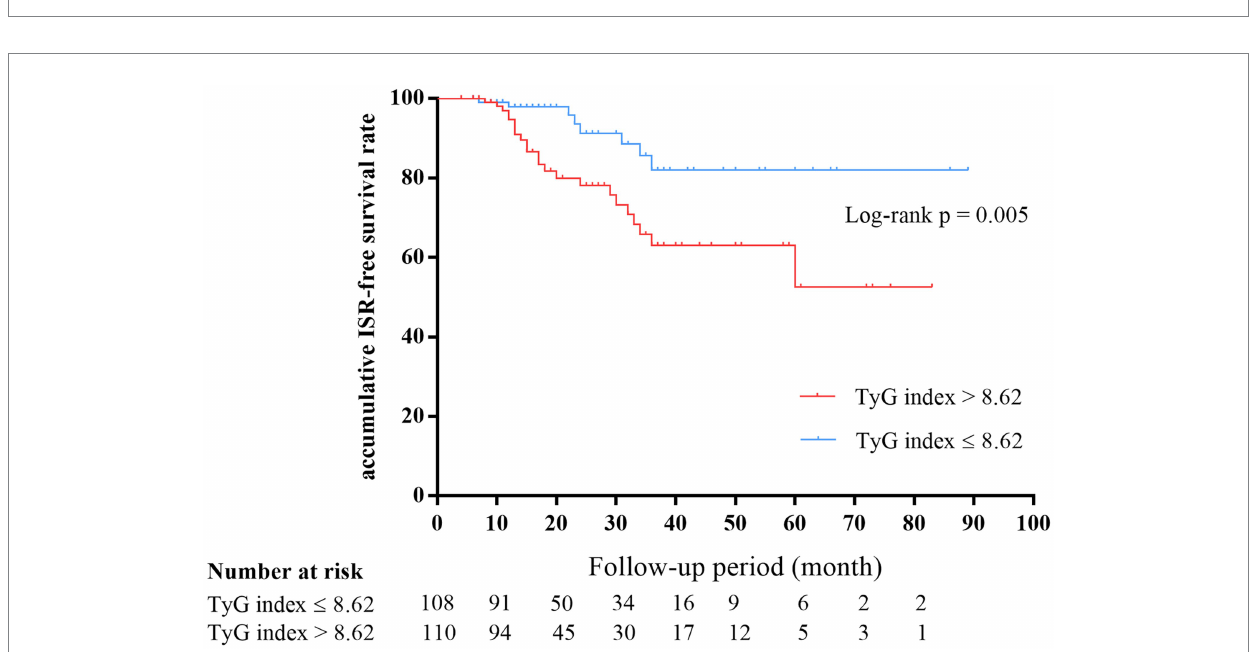
FIGURE 4 Kaplan–Meier survival estimates showed that the cumulative restenosis-free rate in the high TyG index group was significantly lower than that in the low group ( p = 0.005). TyG,